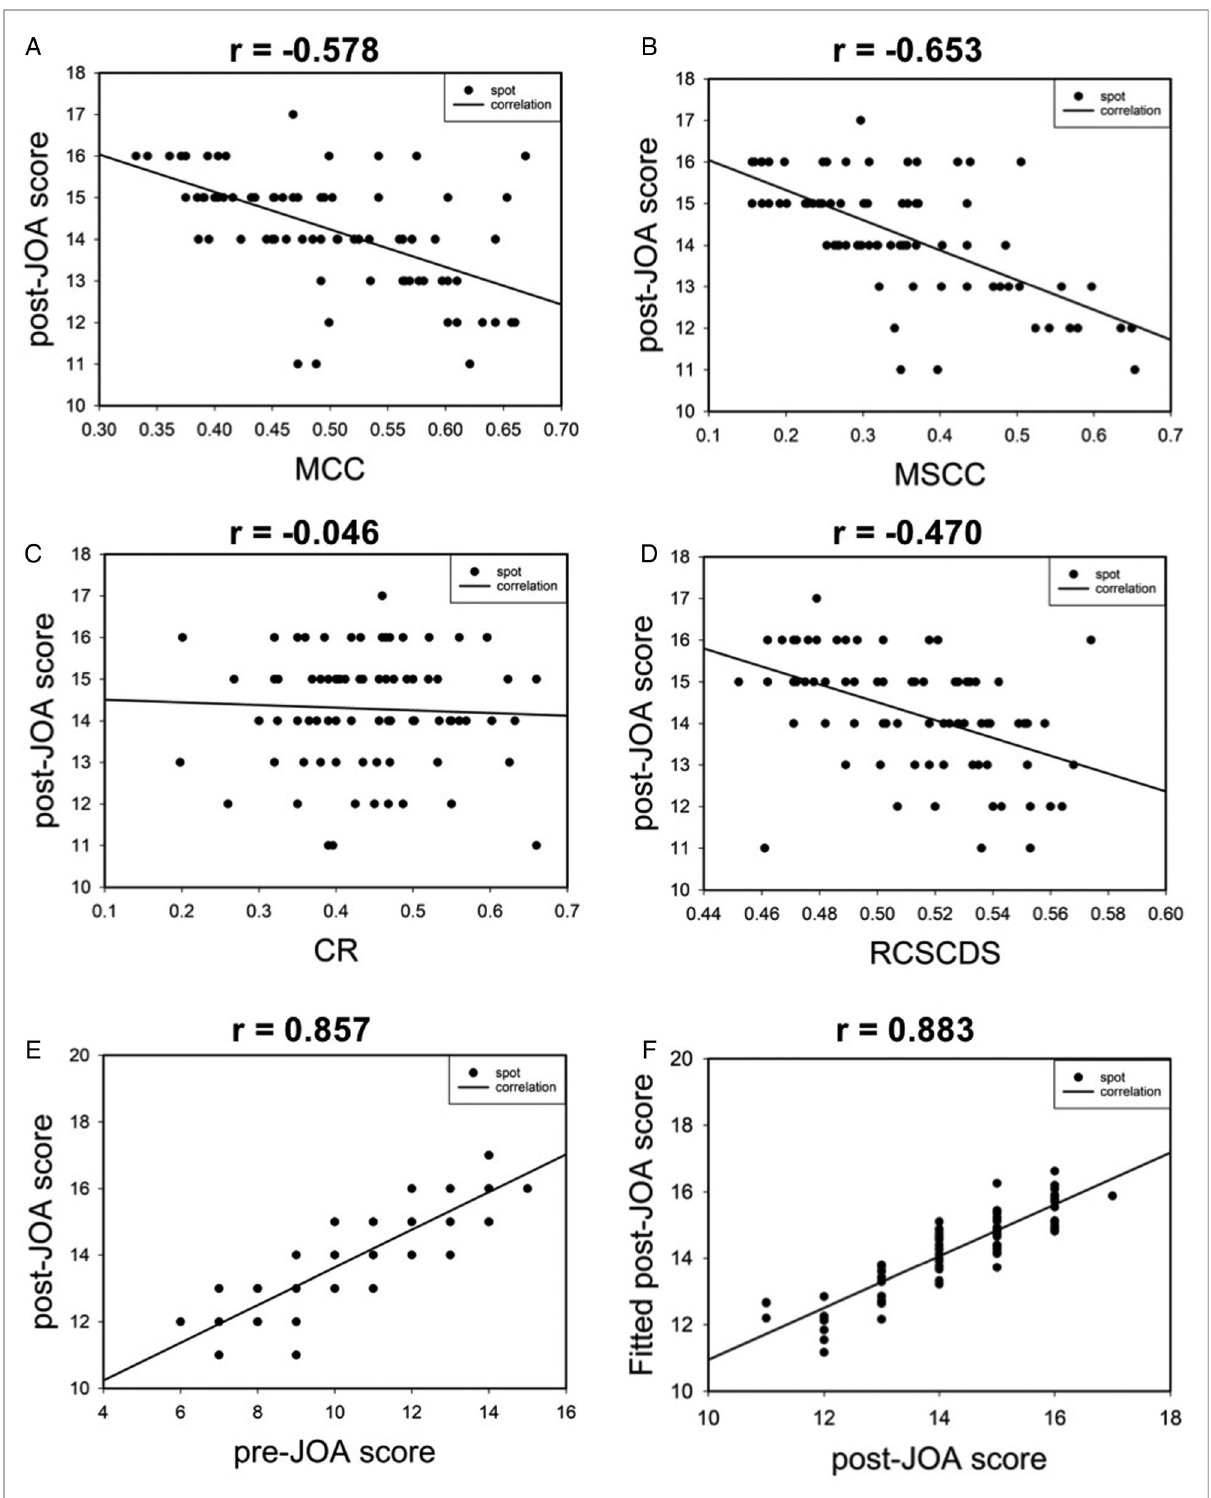
FIGURE 4 The scatter plot of correlation between postoperative JOA score and preoperative spinal cord compression parameters ( A – D ). Correlation between postoperative JOA score and preoperative JOA score ( E ). Correlation between postoperative JOA score and fi tted postoperative JOA score ( F